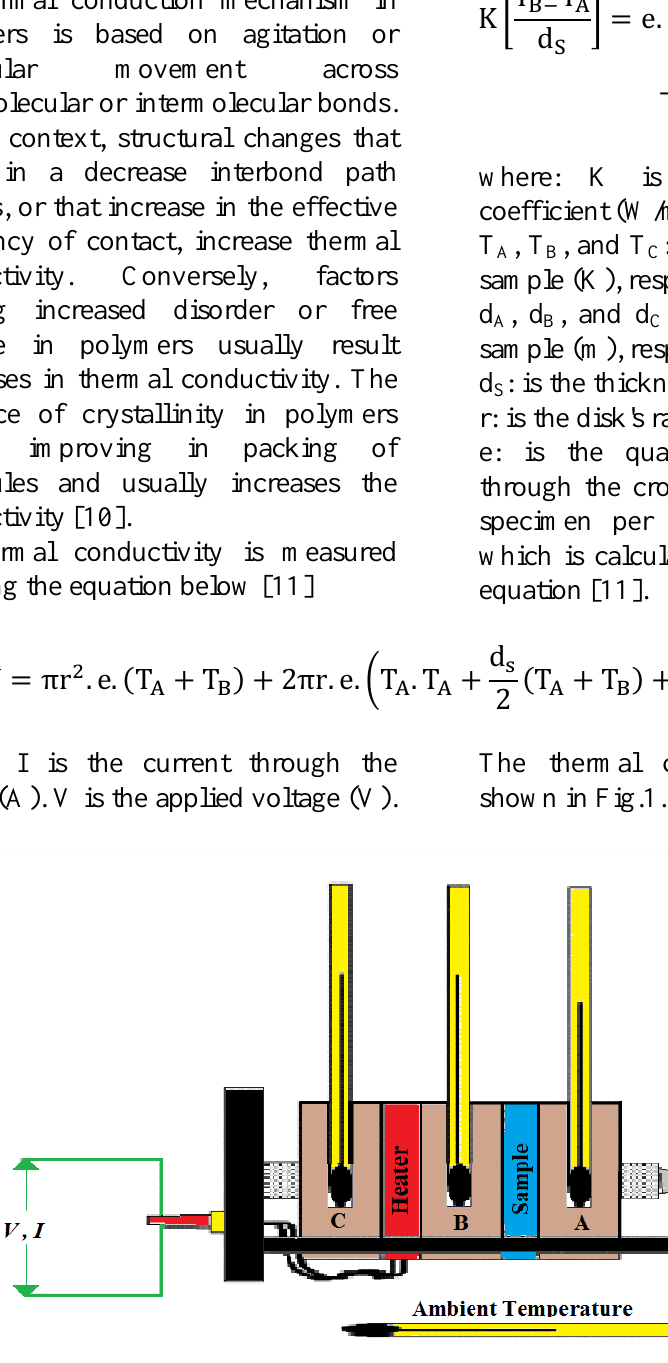
Fig. 1: Scheme of thermal conductivity instrument